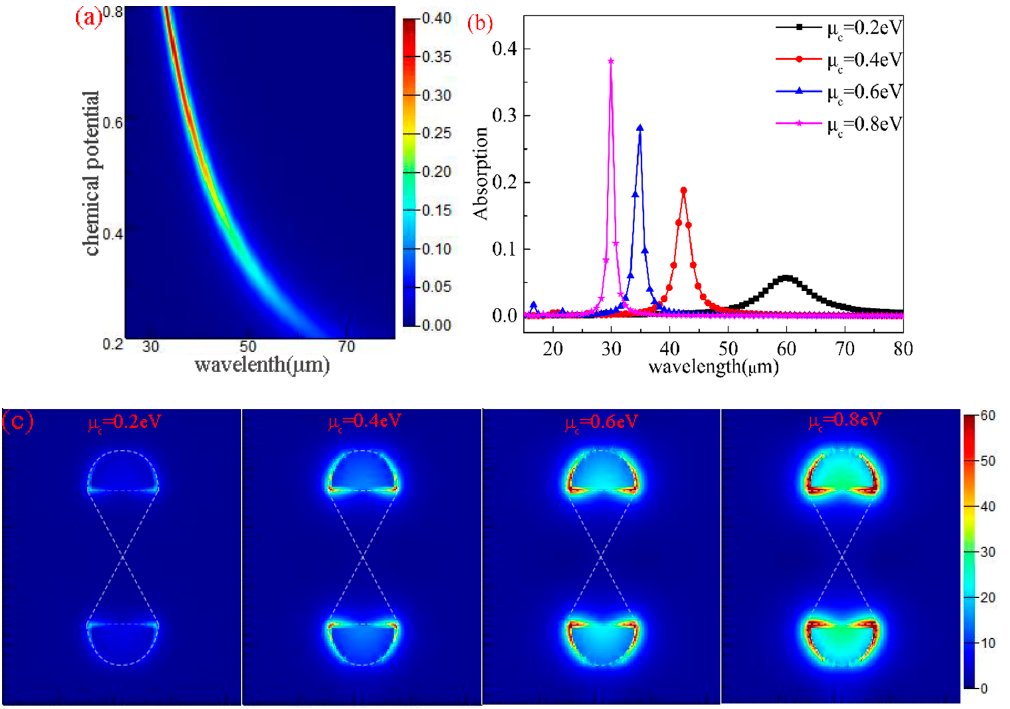
Figure 3. ( a ) The graph of the graphene absorption. ( b ) The absorption spectra corresponding to the chemical potential from 0.2 to 0.8 eV. ( c ) The corresponding electric field intensity distribution under different c μ values.